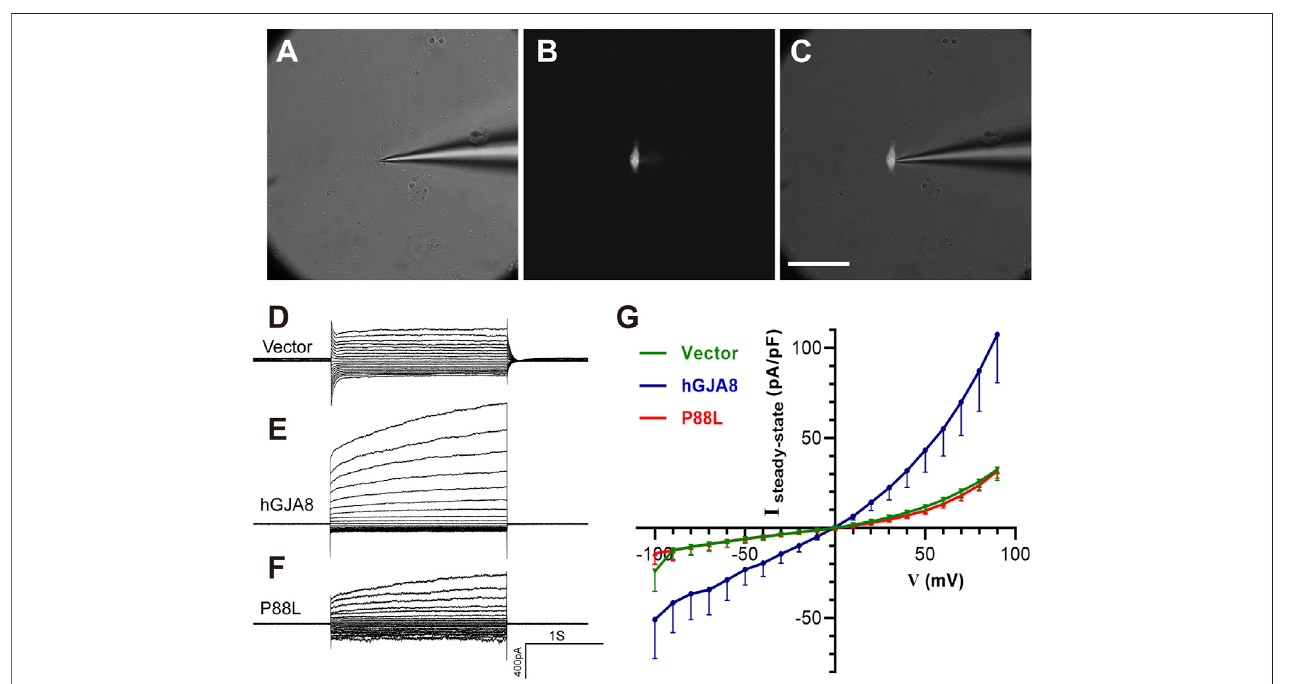
FIGURE 5 | The P88L mutation inhibits hemichannel currents of Cx50 in human LECs. (A – C) Representative images show patch-clamp recordings of isolated GFP-positive cells under white light only (A) , blue light only (B) , and both white and blue lights (C) . Scale bar: 80 µm. (D – F) Steady-state currents from pulses were plotted as a function of membrane voltage. Representative voltage-dependent transmembrane current traces of LECs transfected with pCIG-vector (D) , -hGJA8 (E) or - P88L (F) were measured at a holding potential of 0 mV and subjected to voltage pulses ranging from -100 to 90 mV in 10 mV steps. (G) Population steady-state currentdensity – voltagerelationshipsfromhumanLECsexpressingpCIG-vector,-hGJA8or-P88L.Dataisrepresentedasmean±SEM.Samplesizes: N =12forvector and P88L, N = 11 for hGJA8. p < 0.0001 for interaction and row factor, p = 0.0061 for column factor, with two-way ANOVA analysis.